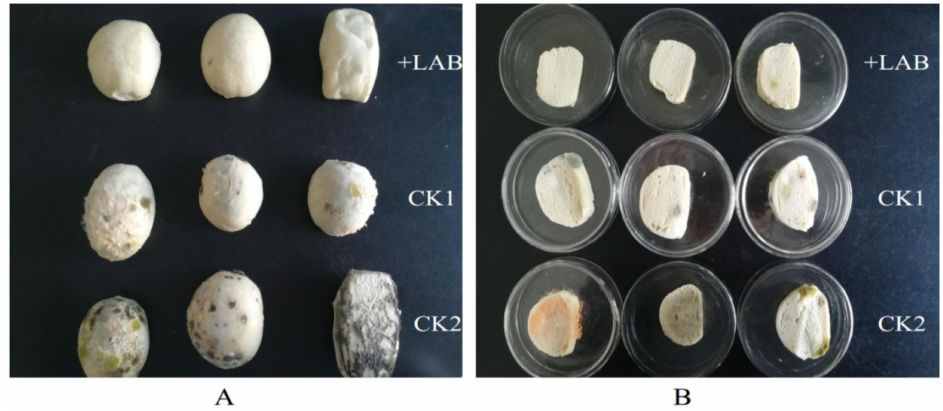
Figure 8. CSB in bag ( A ) and sliced ( B ) steamed bun placed for 6 days. CSB, Chinese steamed buns; LAB, lactic acid bacteria, Batter: 2mL ZZUA493 suspension + 100mL water + 100g flour fermented at 30 ◦ C for 14 h; CK1, Batter: 2 mL water + 100 mL water + 100 g flour fermented at 30 ◦ C for 14 h control; CK2, Batter: 2 mL water + 100 mL water + 100 g flour unfermented